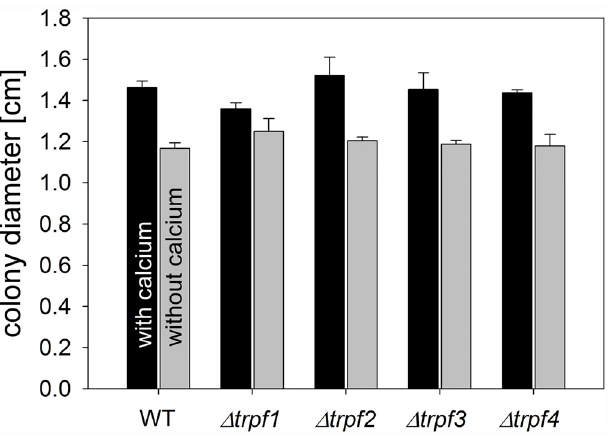
Fig 7. Colony growth of C . graminicola on low-Ca 2+ media. Wild type and deletion strains were grown for 144 h on Ca 2+ -depleted SC media, and colony diameter was determined. Data are means ± SE (N = 3).